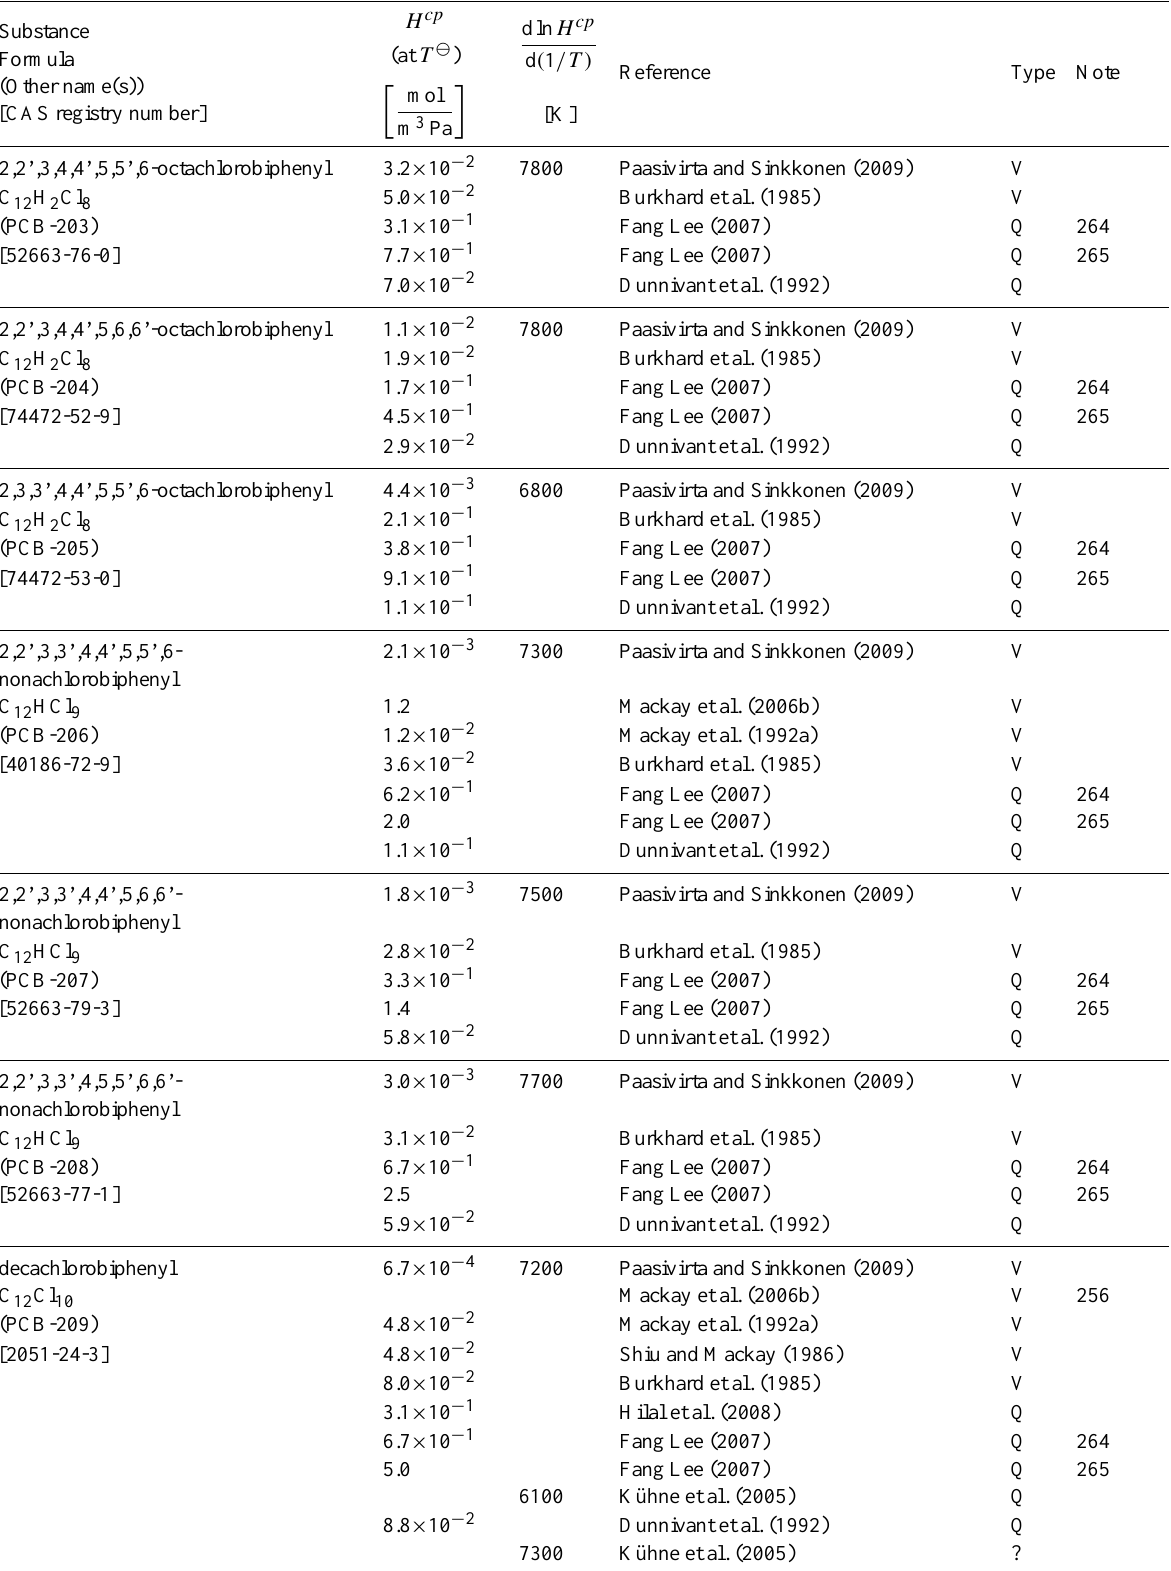
Table 6: Henry’s law constants for water as solvent